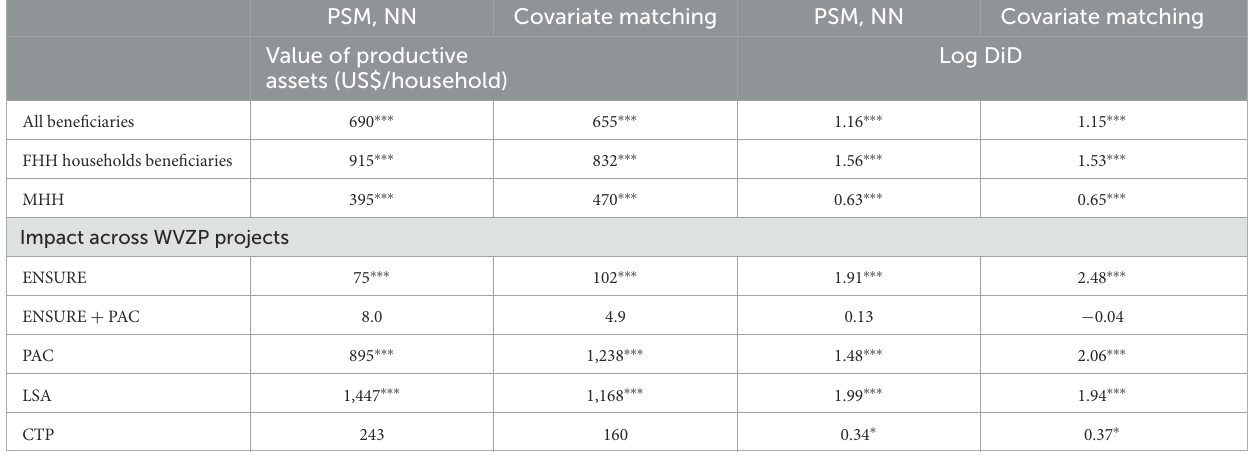
TABLE 11 Impact of WVZP on productive assets. PSM, NN Covariate matching PSM, NN Covariate matching Value of productive assets (US$/household)